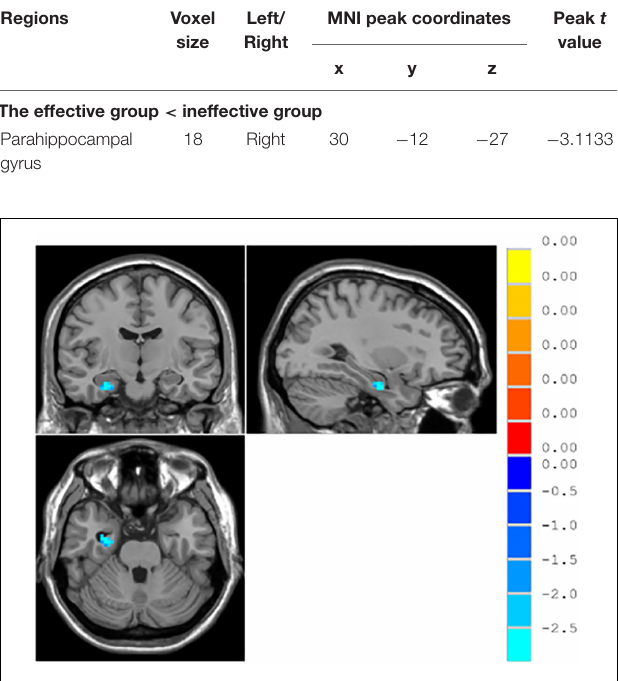
FIGURE 5 | | Brain regions with different resting-state ReHo between the responsive and unresponsive groups.